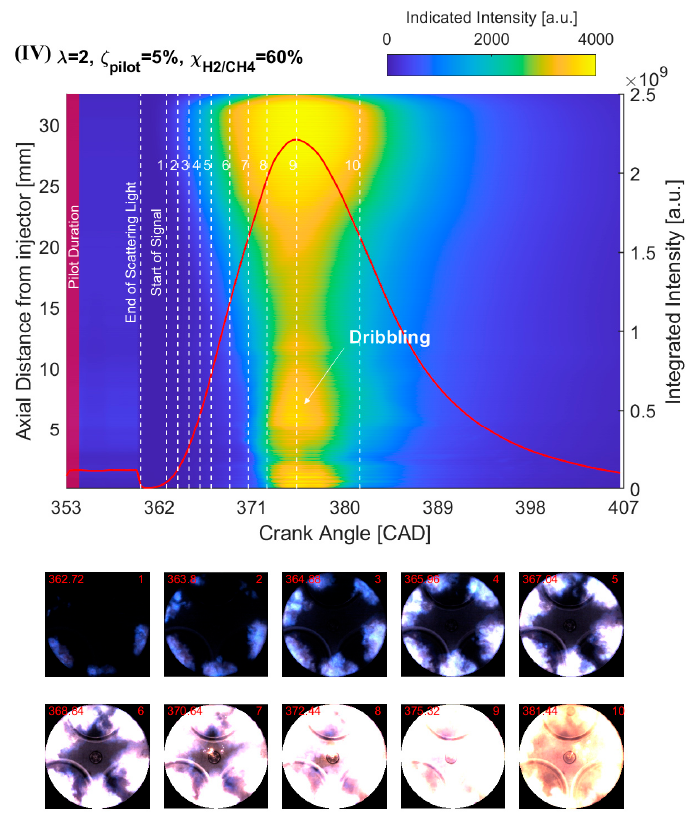
Figure 9. The true-color natural flame luminosity ( bottom ) and axial integrated intensity on the discretized radius ( upper ) of TF combustion under various χ H , ( I ) χ H = 0, ( II ) χ H = 20%, ( III ) χ H = 40%, ( IV ) χ H = 60%. (The red profile is the axial integrated intensity of the flame, and the white lines clarify the timing of the selected images in the axial intensity distribution.) The start of the flame kernel creation and propagation can be applied to define the start of the combustion (SoC) or IDT. In Figure 8, the flame kernels are typically created close to the bowl edge, showing a bluish color due to the intermediate species with band spectra that emit specific wavelengths of light, for instance, self-excited radicals or species such as OH*, HCO*, CH 2 O*, and CH*, which generally have short spectral wavelengths (<500 nm). The continuous broadband spectra of CO 2 * (340 nm-650 nm) might also con- tribute to the emission of short wavelengths [44]. These intermediate radicals or species